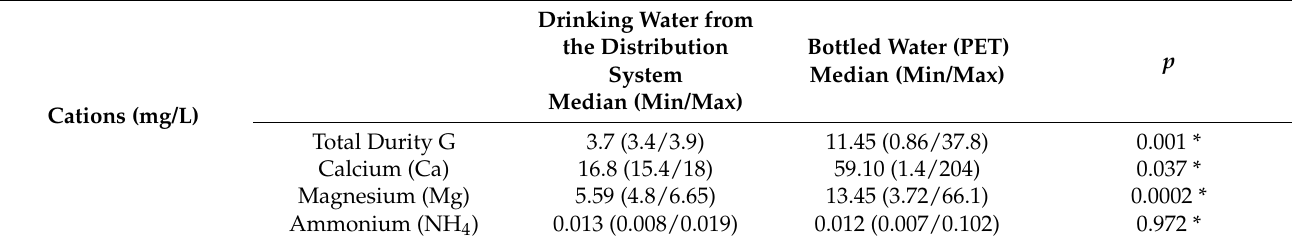
Table 4. Mineral content (cations) in main’s water vs. bottled water.